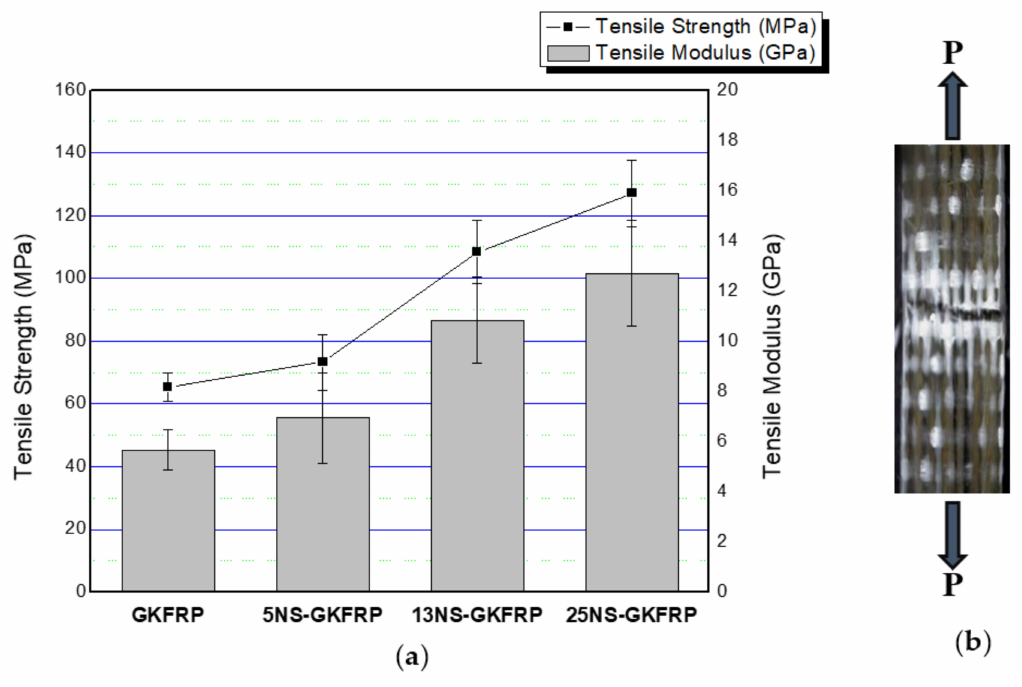
Figure 6. ( a ) Tensile properties of nanosilica-modified GKFRP (5 wt % nanosilica in hybrid woven glass / UD kenaf fiber reinforced polymer composites (5NS-GKFRP), 13 wt % nanosilica in hybrid